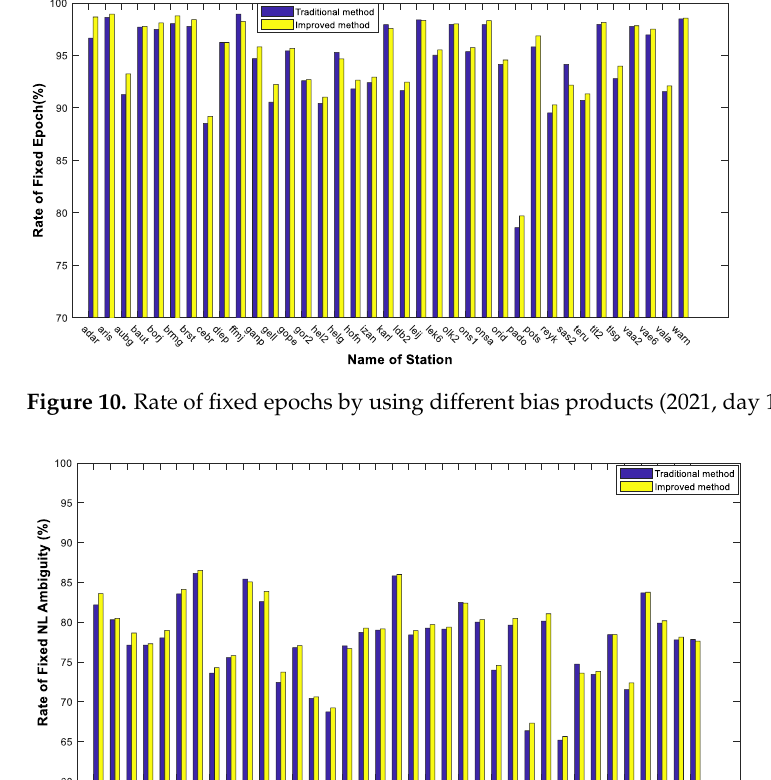
Figure 12. TTFF of 37 stations by static model.